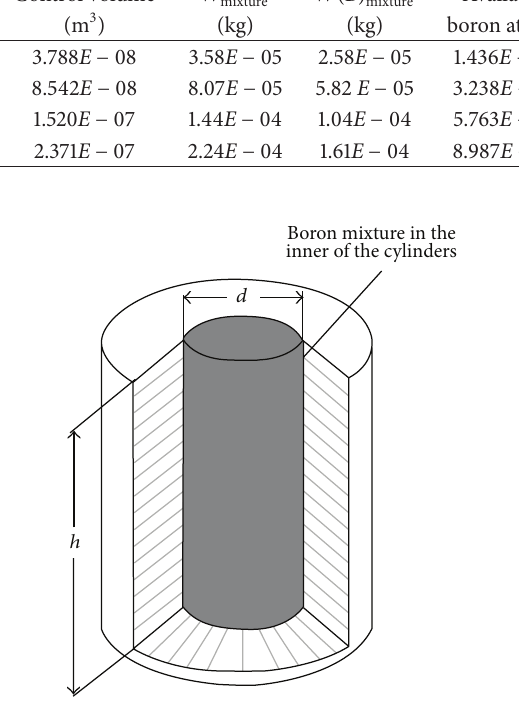
Table 1: Available atoms of boron for the layer formation as a function of the inner diameter of the samples. Sample number Inner diameter of the samples Height of the samples